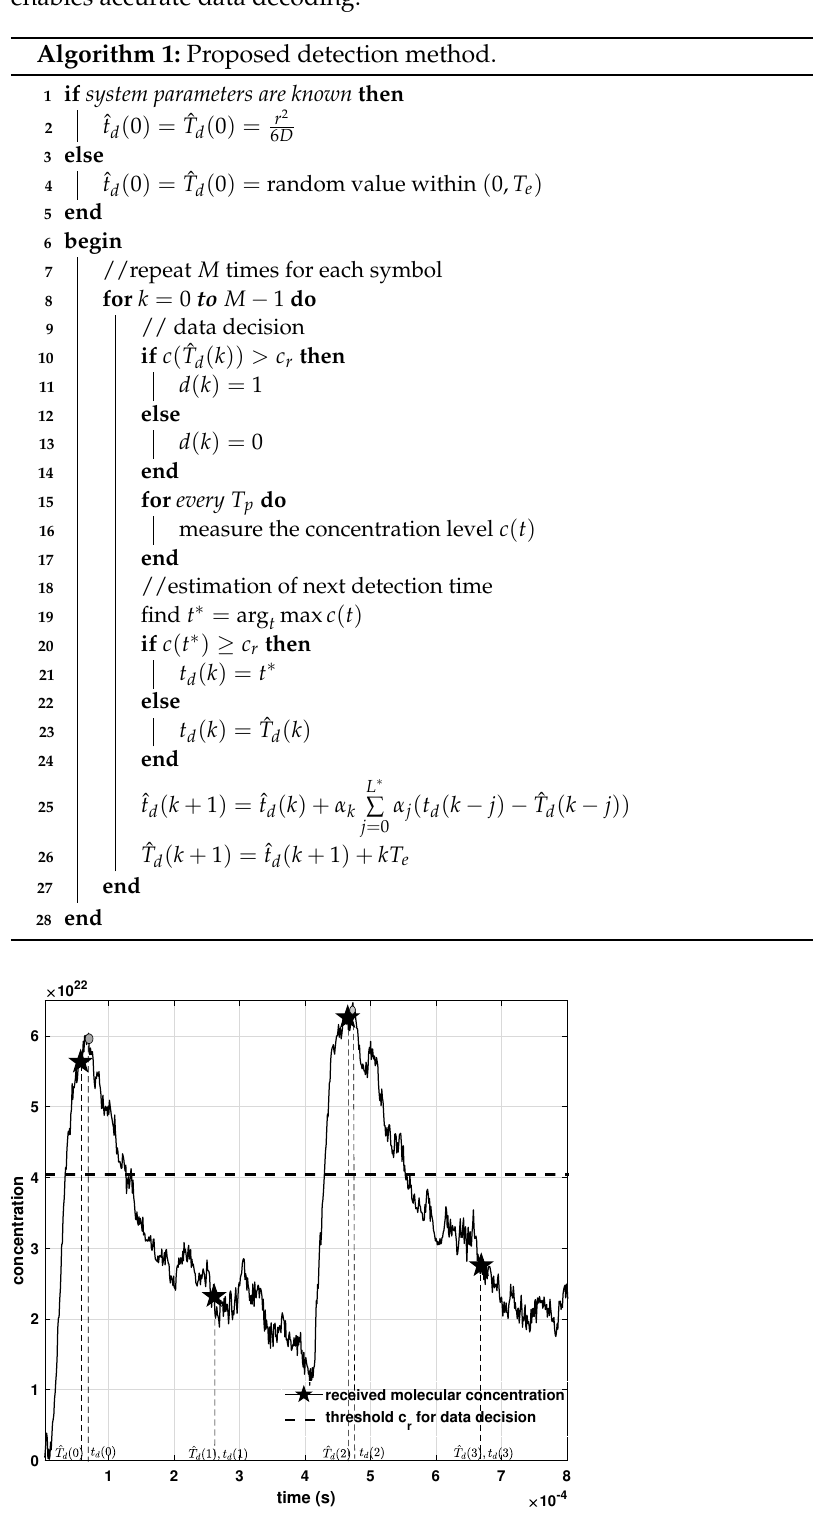
Figure 2. Received molecule concentration at M = 4, T e = 200 µ s, r = 900 nm, Q = 5 × 10 5 , and D = 2.2 × 10 − 9 m 2